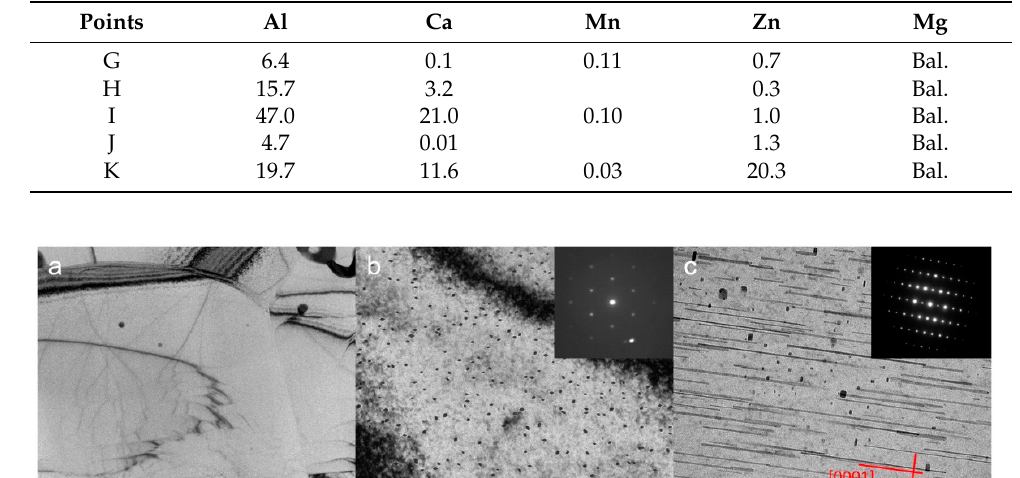
Figure 7. STEM images of homogenized ( a ) ZAXM2100 and ( b ) ZAXM4100 alloy sheets. Table 2. Chemical composition (in at.%) of the matrix and particles in homogenized ZAXM2100 and 4100 alloys indicated by yellow arrows inserted in Figure 8.